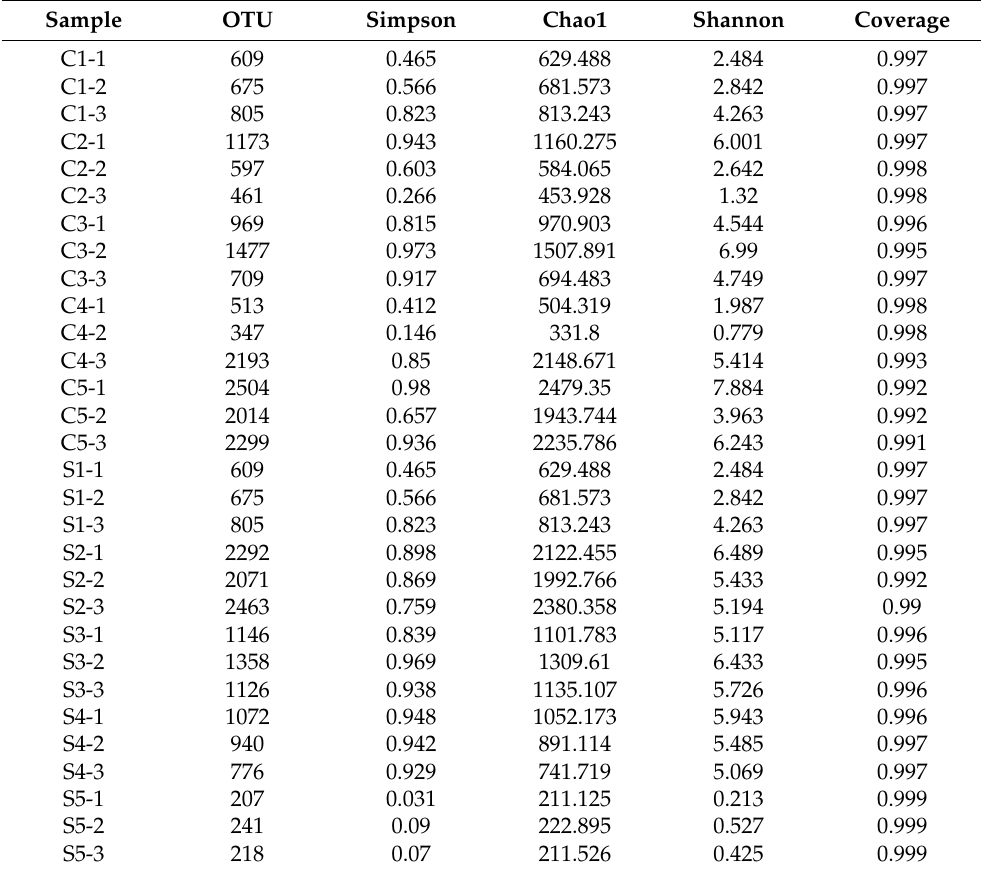
Table 3. Illumina high-throughput data, bacterial diversity richness (OTUs), and diversity indices (Shannon & Simpson) for intestinal bacterial diversity analysis of silver pomfret fed with different diets for 20